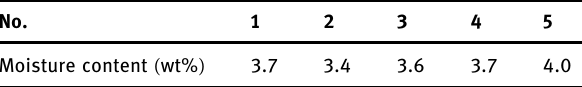
Table 14: Moisture content of the converter slagging agent No.